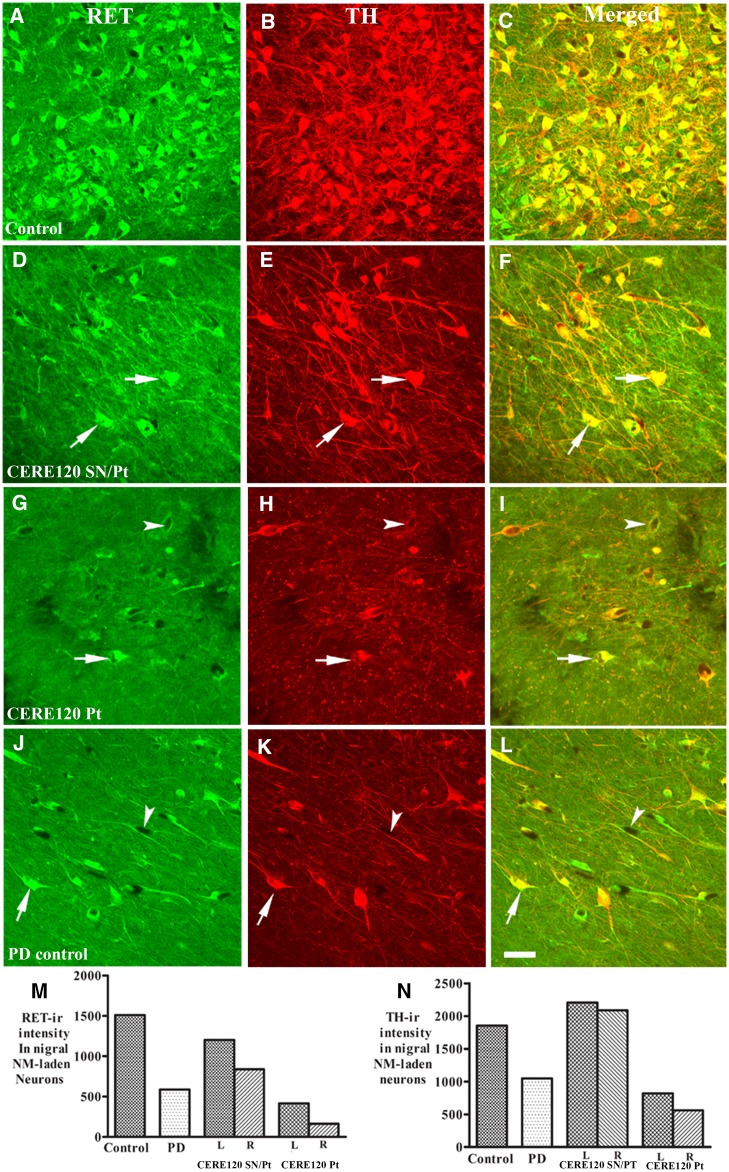

Co-localization analyses of RET and TH expression in nigral neurons. Confocal microscopy images of substantia nigra from age-matched control (A–C), Parkinson’s disease with combined nigral and putamenal CERE120 delivery (CERE120 SN/Pt; D–F), Parkinson’s disease with putamenal CERE120 delivery only (CERE120 Pt; G–I), and Parkinson’s disease without gene delivery (J–L) illustrating Ret (green; A, D, G and J), TH (red; B, E, H and K), and co-localization of Ret and TH (merged; C, F, I and L). In age-matched control (A–C), strong Ret (A) and TH (B) immunoreactivities were co-localized in the nigral neurons (C). Remaining nigral neurons in Parkinson’s disease with combined nigral and putamenal CERE120 delivery displayed intense Ret (arrows; D) and TH (arrows; E) that were co-localized in melanized neurons (arrows; F). However, Ret immunoreactive intensity was markedly low in subject with putamenal CERE120 delivery only (G) similar to Parkinson’s disease (J) without gene delivery. Some remaining melanized neurons had light Ret (arrows; G) and TH (arrow; H) immunostaining and other exhibited undetectable Ret (arrowheads; G) and TH (arrowheads; H). Scale bar in L = 100 µm (applies to all). Quantitation of immunofluorescent intensities revealed that the optical density values of Ret (M) and TH (N) in Parkinson’s disease with combined nigral and putamenal CERE120 delivery were similar to age-matched control whereas subject with putamenal CERE120 delivery only were close to Parkinson’s disease without gene delivery. The optical densities of RET and TH immunofluorescent intensities were measured from nigral neurons with neuronal melanin. PD = Parkinson’s disease; ir = immunoreactivity.